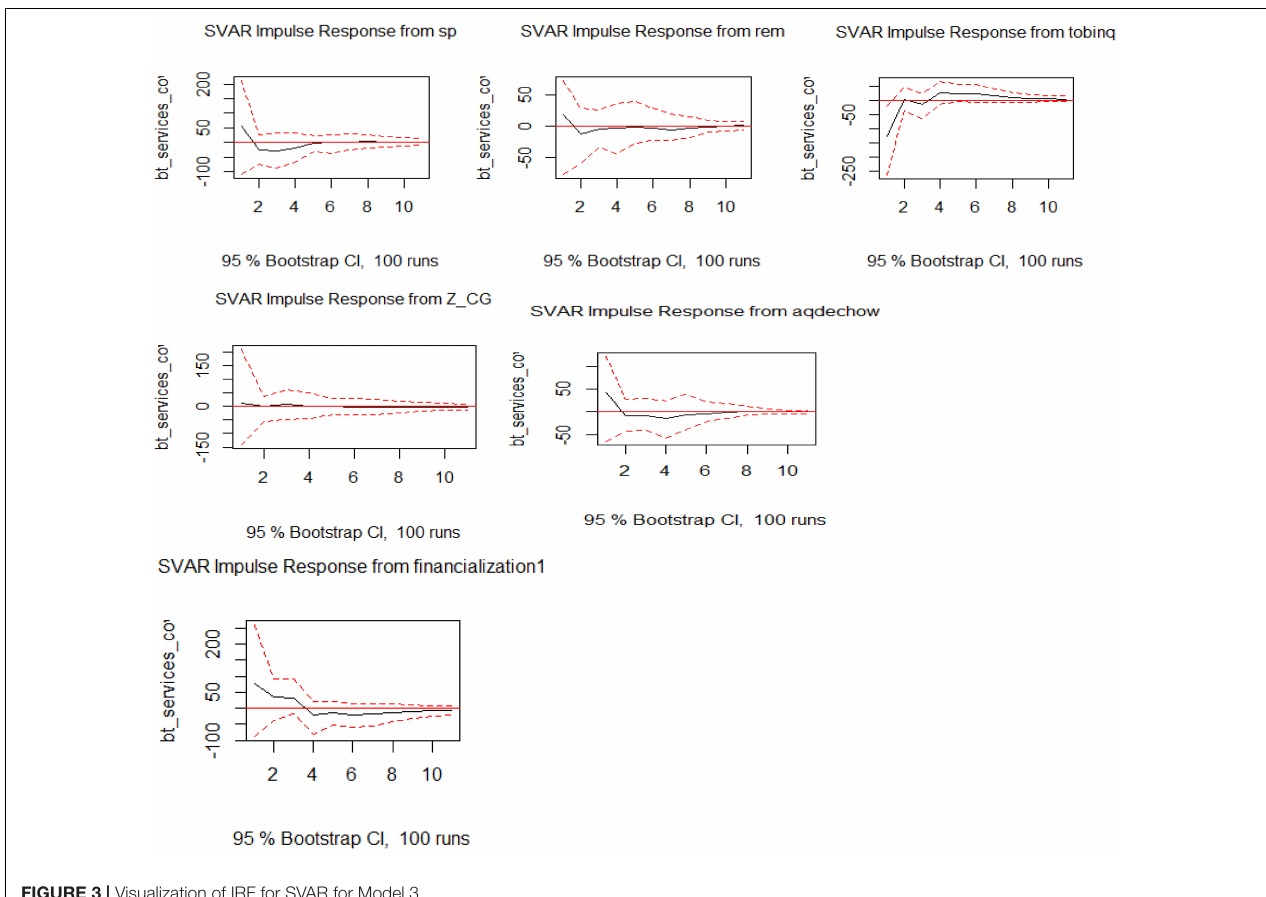
FIGURE 3 | Visualization of IRF for SVAR for Model 3.